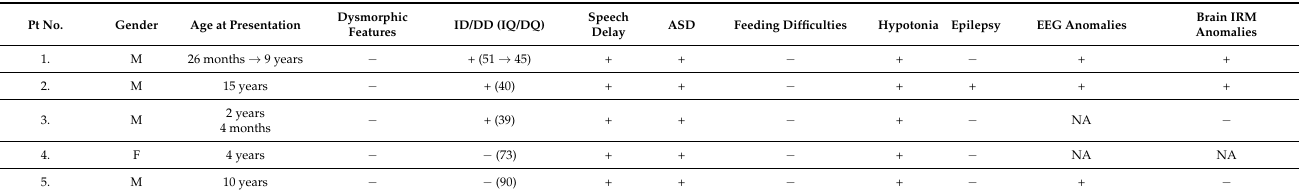
Table 1. The clinical characteristics of the patients.